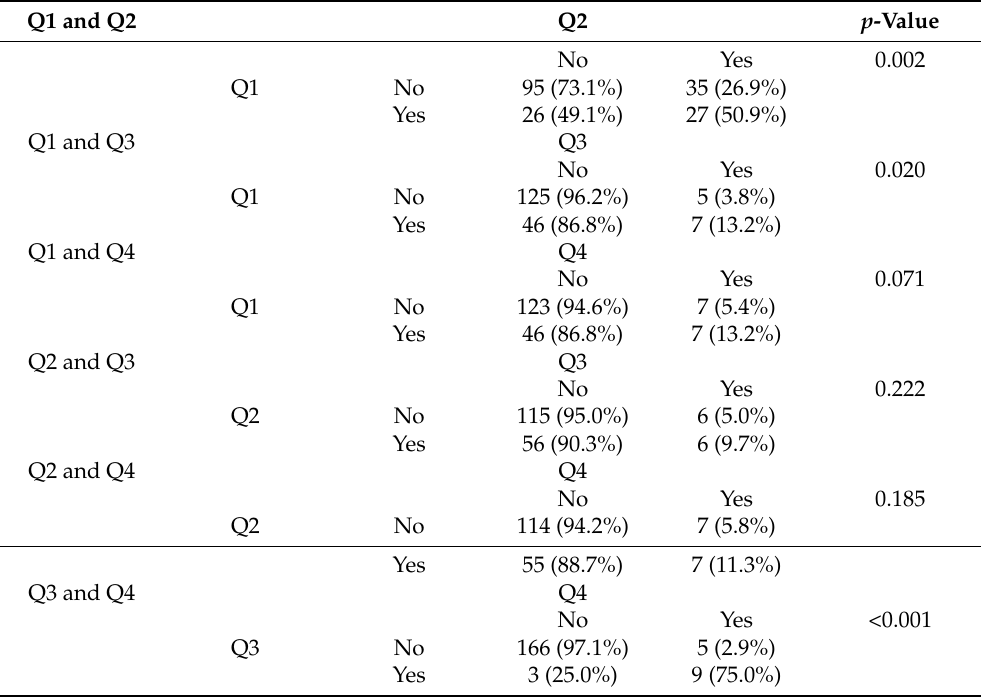
Table 4. Tooth agenesis between quadrants: inter-quadrant